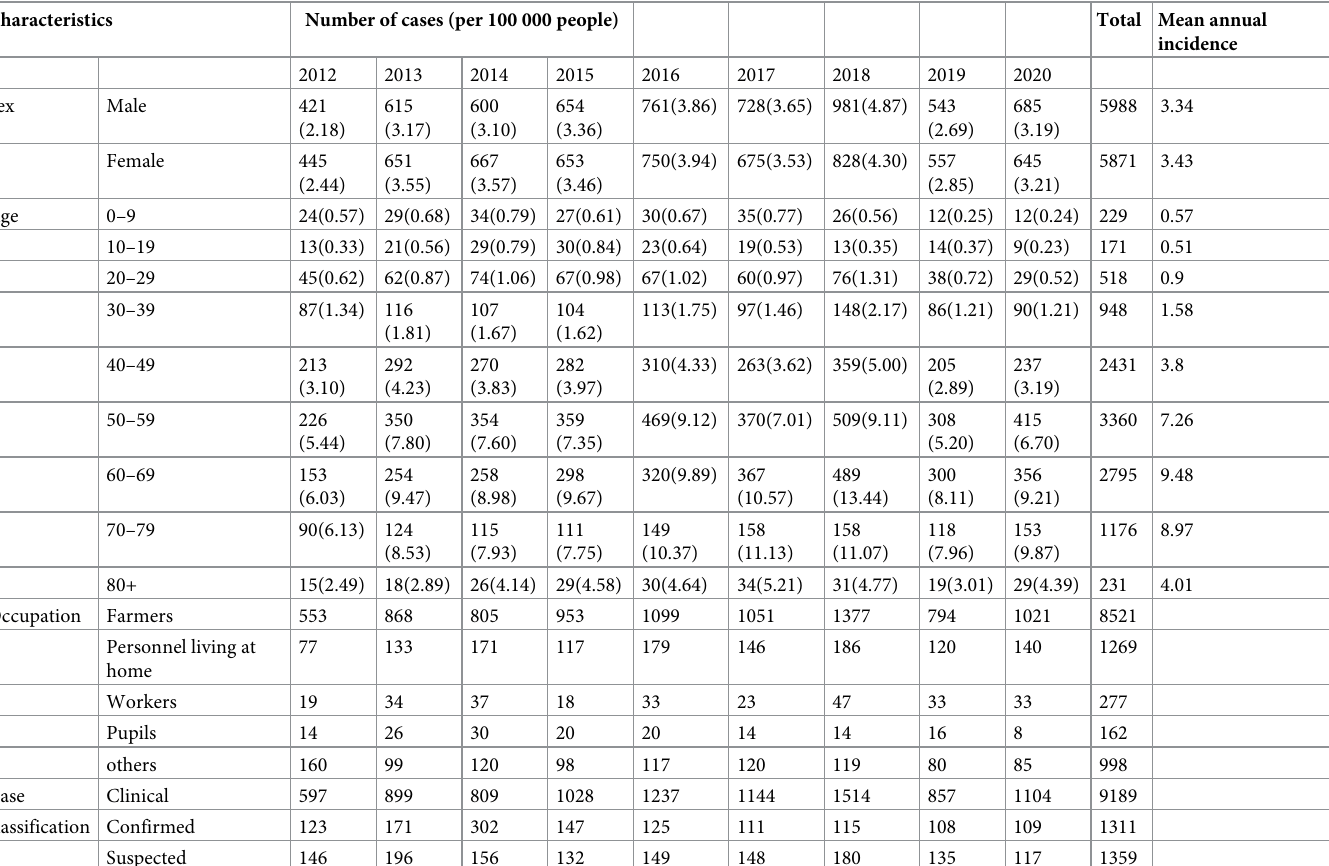
Table 1. Annual number of scrub typhus cases and incidence rate by sex, age and occupation and the proportion of classified cases in Fujian Province, 2012–2020.